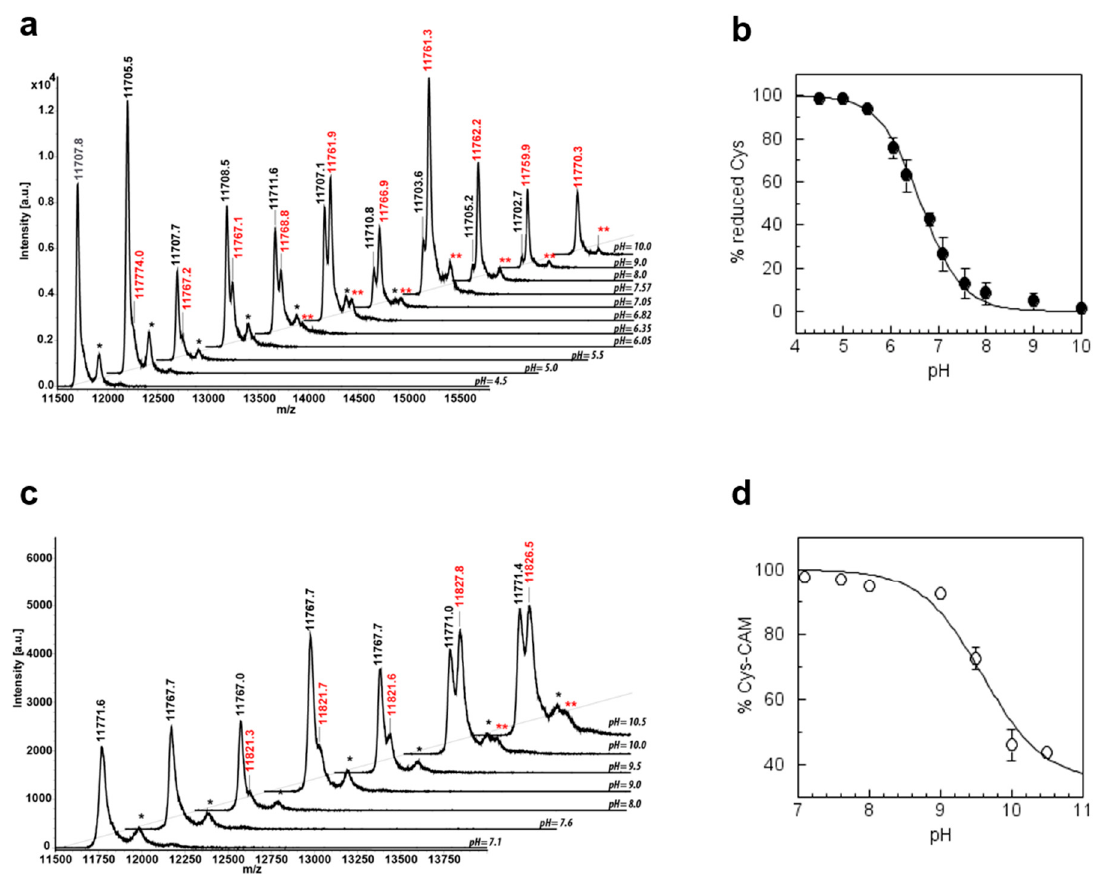
Figure 7. p K a determination of active site cysteines . ( a ) Reduced CrTRXh1 was incubated with 2-fold excess of IAM at pH values ranging from 4.5 to 10 for 105 seconds before the reaction was quenched (see Material and Methods). Parental/monoalkylated (CrTRXh1-SH/CrTRXh1-CAM) protein ratios were determined by digital integration of MALDI-TOF mass spectrometry peaks labeled in black (CrTRXh1-SH) and red (CrTRXh1-CAM). The spectra are displayed as a function of pH. Matrix adducts for CrTRXh1-SH (one black asterisk) and CrTRXh1-CAM (two red asterisks) are indicated. ( b ) The fraction of reduced CrTRXh1 was measured by mass spectrometry as described in ( a ). The p K a values was obtained by nonlinear regression using an adaptation of the Henderson–Hasselbalch equation [50]. Experimental data are displayed as mean ± SD ( n = 3) and fitted to a full sigmoid. ( c ) Reduced CrTRXh1 was treated with 2-fold excess of IAM at pH 7 prior to incubation at pH values ranging from 4.5 to 10 for 2 min in the presence of 10-fold excess of IAM. After incubation, the reaction was quenched as in ( a ). Monoalkylated/dialkylated (CrTRXh1-CAM/CrTRXh1-CAM-CAM) protein ratios were determined by digital integration of MALDI-TOF mass spectrometry peaks labeled in black (CrTRXh1-CAM) and red (CrTRXh1-CAM-CAM). The spectra are represented as a function of pH. Matrix adducts for CrTRXh1-CAM (one black asterisk) and CrTRXh1-CAM-CAM (two red asterisks) are indicated. ( d ) The fraction of monoalkylated CrTRXh1 was measured by mass spectrometry as described in ( c ). The p K a values were obtained by nonlinear regression as described above. Experimental data are displayed as mean ± SD ( n = 2) and fitted to a full sigmoid.